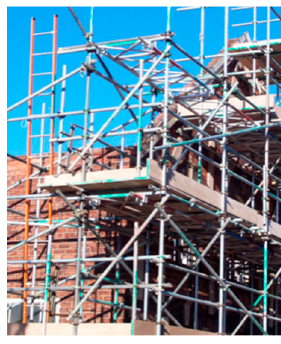
Figure 5. “Tube ‐ and ‐ fittings” scaffolding [10]. Figure 5. “Tube-and-fittings” scaffolding